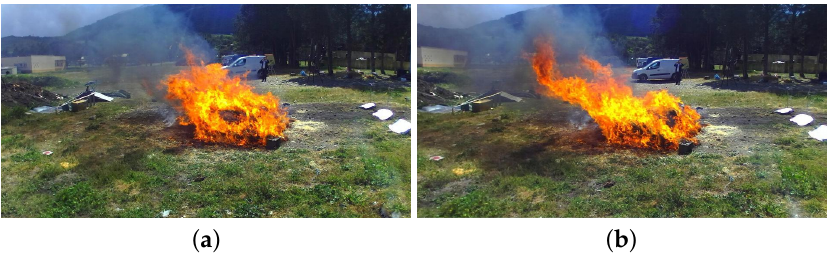
Figure 22. Images of the pseudo-static fire at two different moments: ( a ) at t = 92 s and ( b ) at t = 100 s. At each instant, from the estimated fire points situated on the ground, the front line was